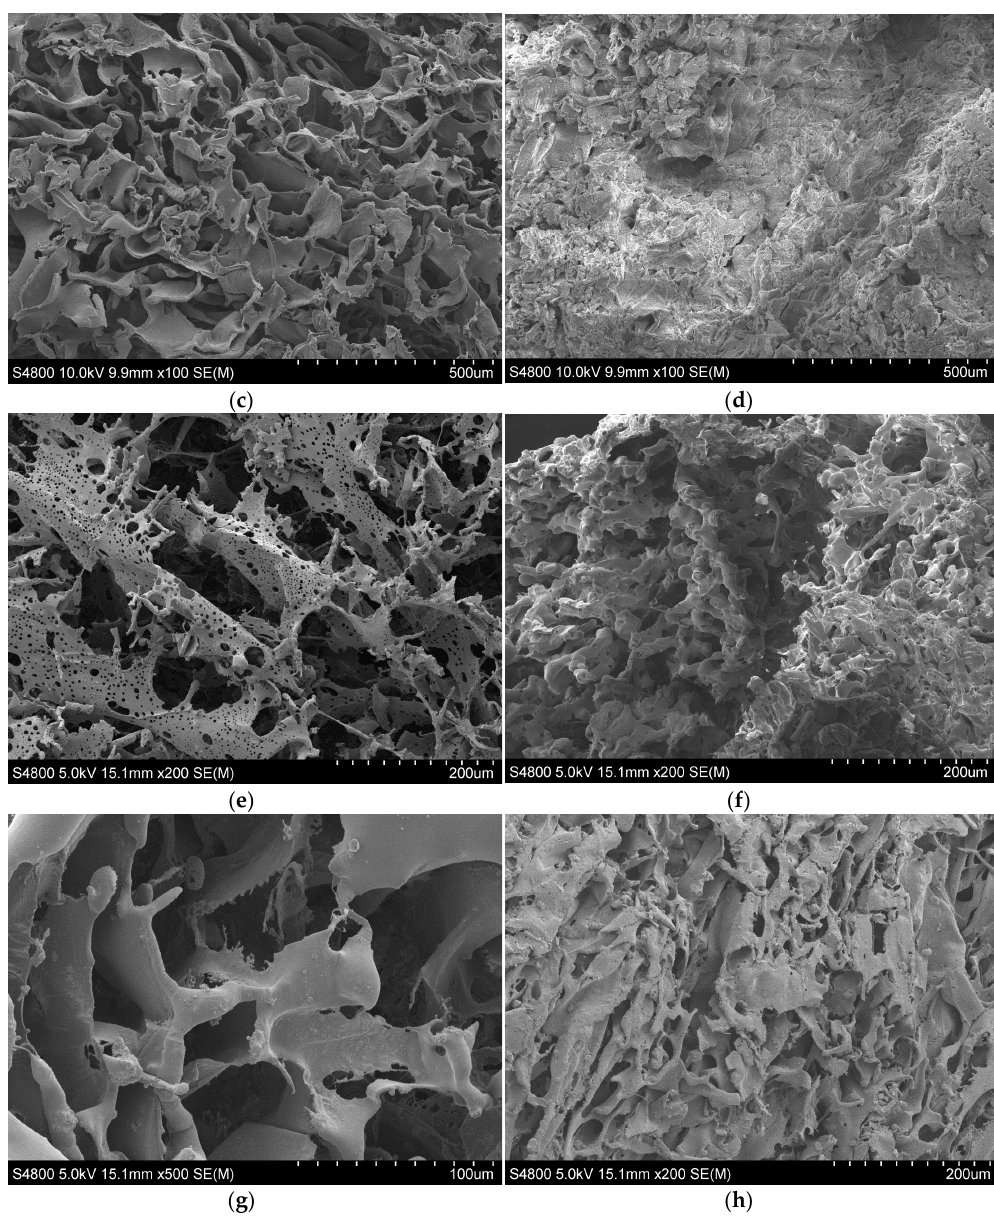
Figure 8. SEM observation of surface morphology of PLGA. ( a ) PLGA (53/47) before degradation; ( b ) PLGA (53/47) after in vitro degradation for three weeks; ( c ) PLGA (53/47)/nHA 50% before degradation; ( d ) PLGA (53/47)/nHA 50% after in vitro degradation for six weeks; ( e ) PLGA (75/25) before degradation; ( f ) PLGA (75/25) after in vitro degradation for eight weeks; ( g ) PLGA (75/25)/nHA 50% before degradation; ( h ) PLGA (75/25)/nHA 50% after in vitro degradation for eight weeks. During the in vitro degradation in the porous scaffold of PLGA 75/25, microporosity was disappearing at the same time as the scaffold started to lose its form. Erosion was evident from the first week, and from the fourth week, the structure of the scaffold started to collapse. After the first week of degradation, a change in the surface morphology was appreciated in the porous scaffolds of PLGA 53/47 that went from having a smooth appearance to a more rugged one. This change is without a doubt due to the degradation, which started to free its products, exposing them together with particles of nHA on the walls of the scaffold. The formation of these precipitates on the surface